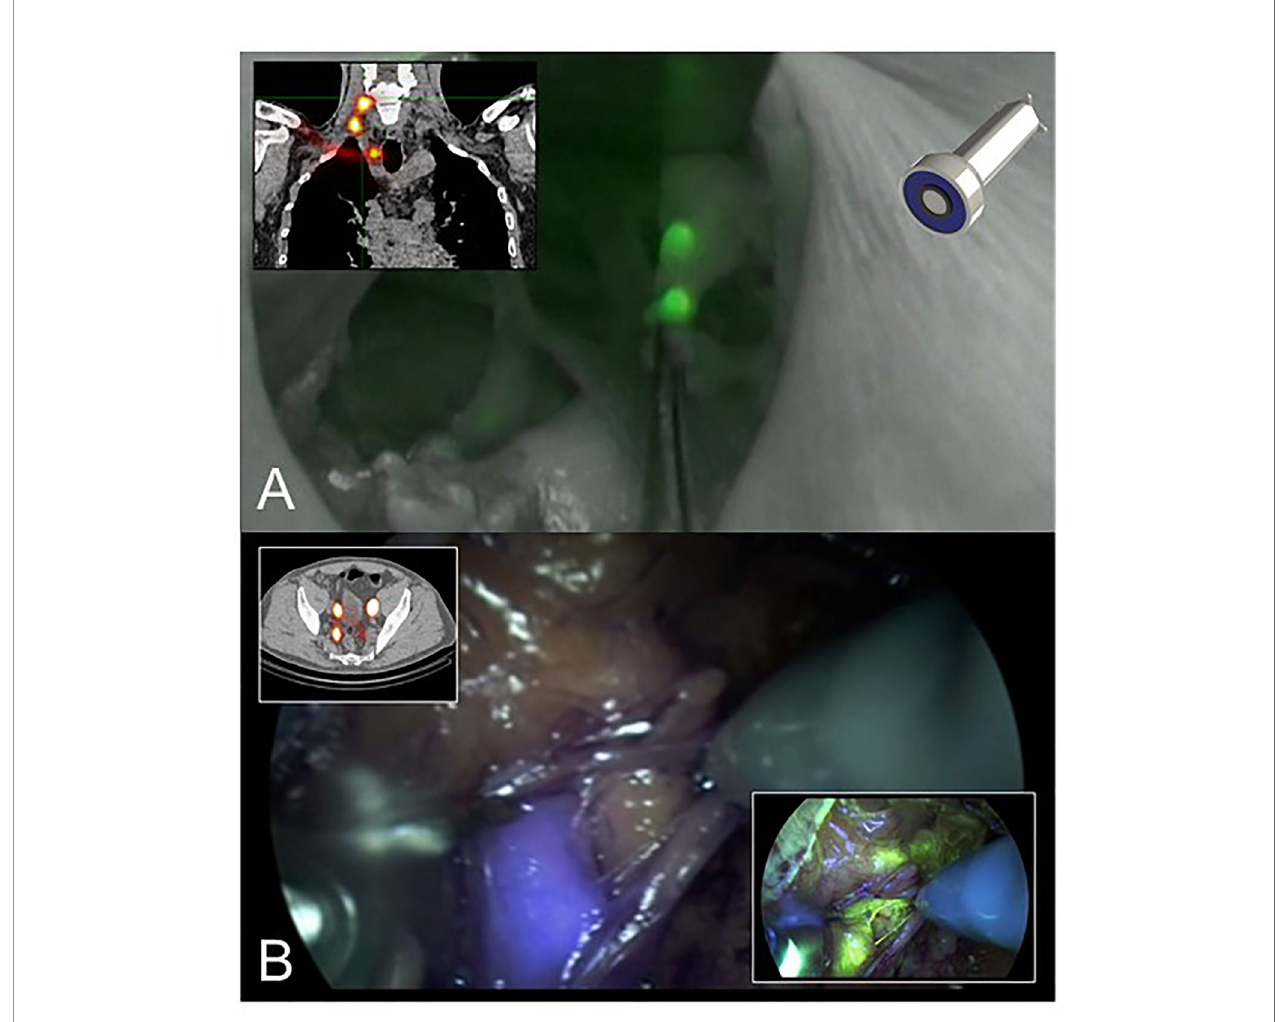
FIGURE 1 | (A) The hybrid tracer ICG-99mTc-nanocolloid helps allying intraoperative fl uorescence imaging with preoperative SPECT/CT data. This example shows SLN-biopsy in the head-and-neck region that was performed with the ambient lights on in the operation room (9). (B) Multi-color fl uorescence imaging using the hybrid tracer ICG-99mTc-nanocolloid (preoperative SPECT/CT and blue) and fl uorescein (yellow). This example shows robot-assisted SLN-biopsy in prostate